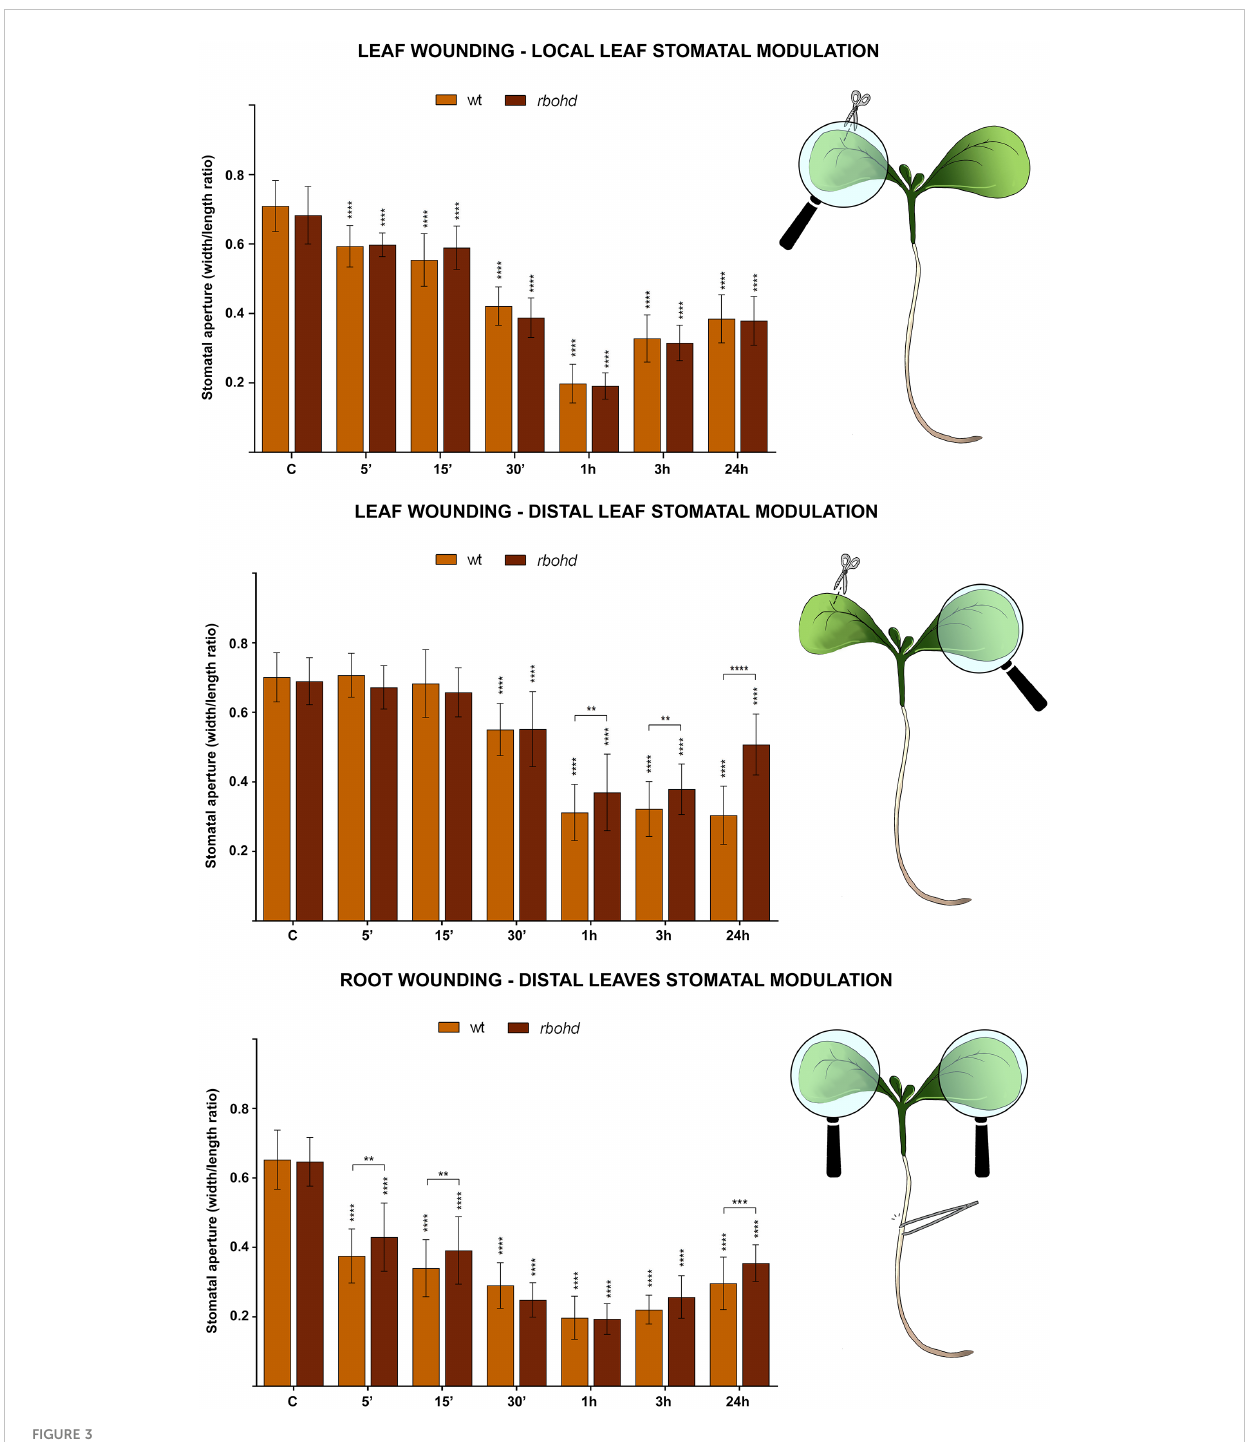
FIGURE 3 Effect of cotyledonary-leaf wounding and root wounding on stomatal pore modulation of 7-day-old WT and rbohd mutant seedlings. Cotyledonary-leaf or root was injured and seedlings were incubated for 5 min, 15 min, 30 min, 1 h, 3 h, and 24 h. After cotyledonary-leaf wounding, analyses of stomatal pore modulation were carried out separately measuring stomata in wounded cotyledonary-leaves (local effect, top panel) and stomata in distal unwounded cotyledonary-leaves (distal effect, middle panel). After root wounding, analyses of stomatal pore modulation were carried out measuring stomata randomly chosen from both cotyledonary-leaves of each seedling (distal effect, bottom panel). Mean values ± SD ( n = 15) are reported. Signi fi cance levels between unwounded seedlings (C) and wounded seedlings of each genotype are reported. p levels have been calculated with one-way ANOVA analysis; p levels > 0.05; **, ***, and **** p levels ≤ 0.01, 0.001, and 0.0001, respectively. If not shown, the statistical difference is not signi fi